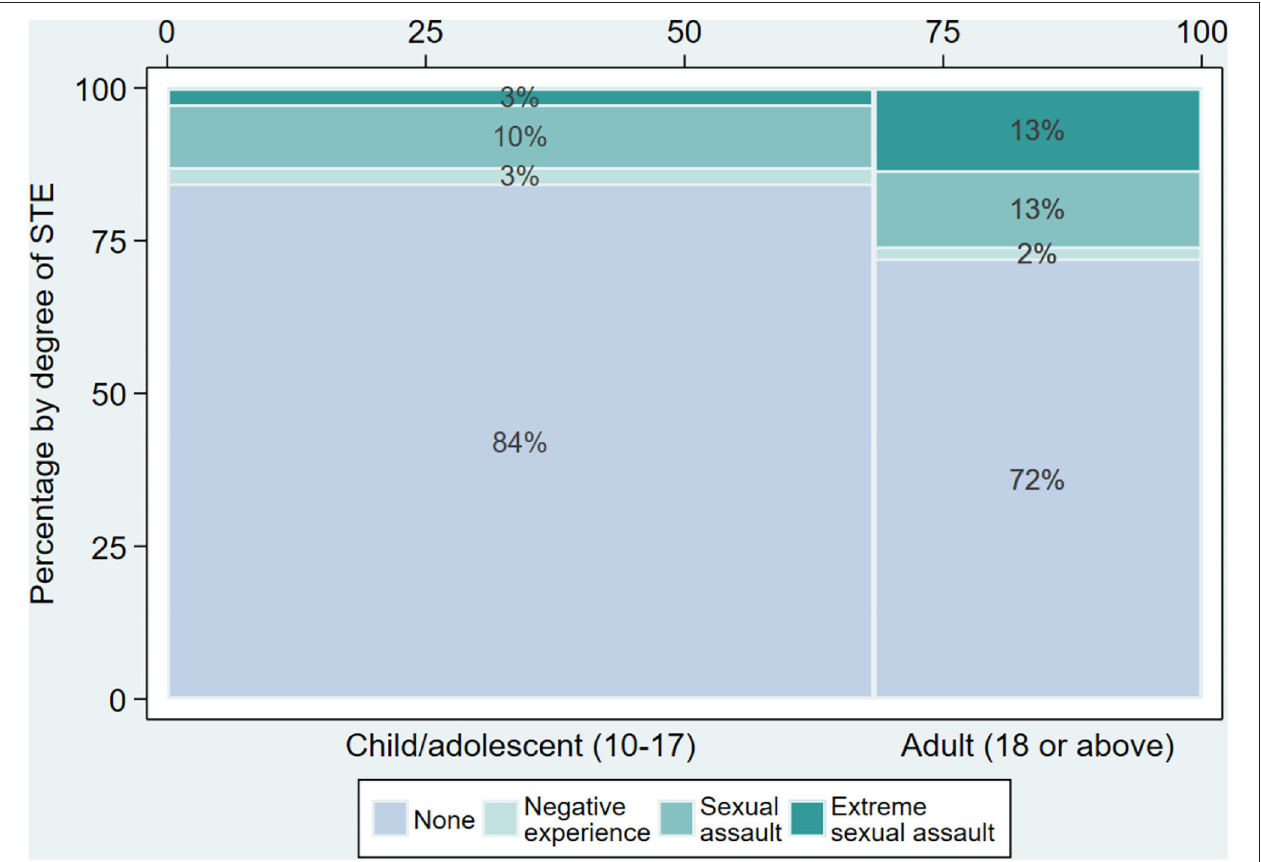
FIGURE 4 | Severity of STE for children/adolescents and adults. This figure displays the distribution of presence and severity of STE divided by age group [ N = 329, for children/adolescents ( N = 225) and adults ( N = 104), respectively]. The percentages are within each age group. The thickness of the bar for each age group reflects the size of the group (see percentage bar at the